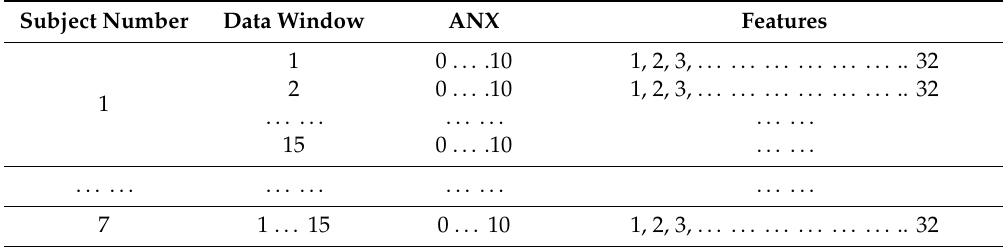
Table 2. Experimental data organization for